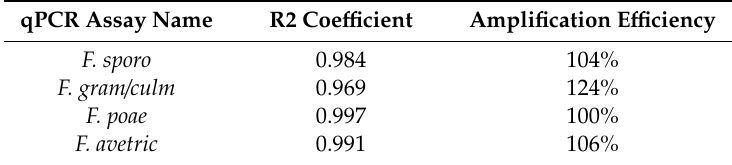
Table 3. The R2 coe ffi cients and amplification e ffi ciencies of the four assays targeting Fusarium species were calculated in qPCR with the standard curve approach, using six calibration points with three PCR replicates each and the formula E = 10 − 1 /